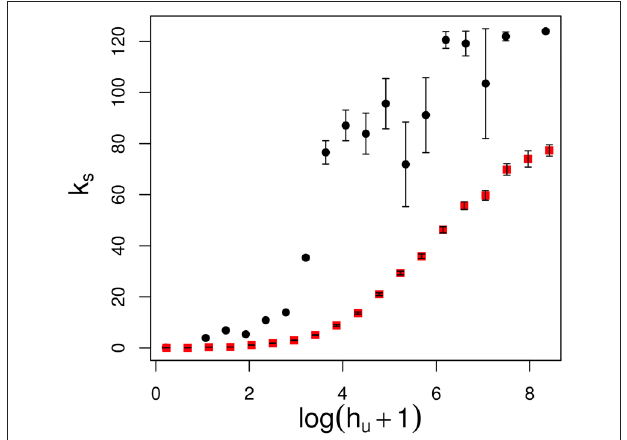
FIGURE 9 | Dependency of the k s value given the logarithm of the helpfulness of its users (DY in red, EP in black). Points are mean values of k s and error bars are standard error. Helpfulness serves as a predictor for coreness in both communities.